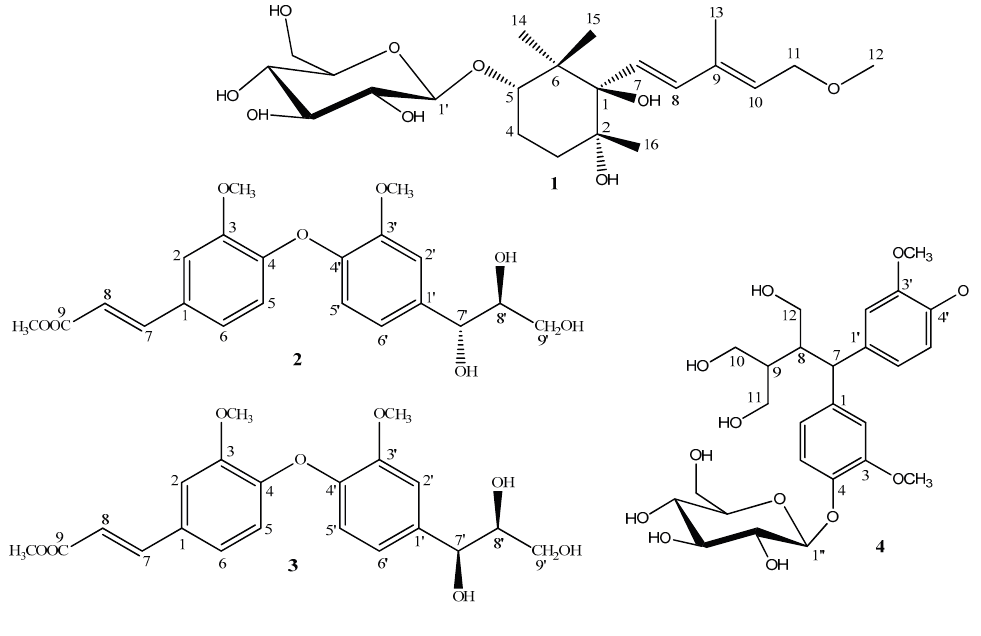
Figure 1. Structures of compounds 1 – 4